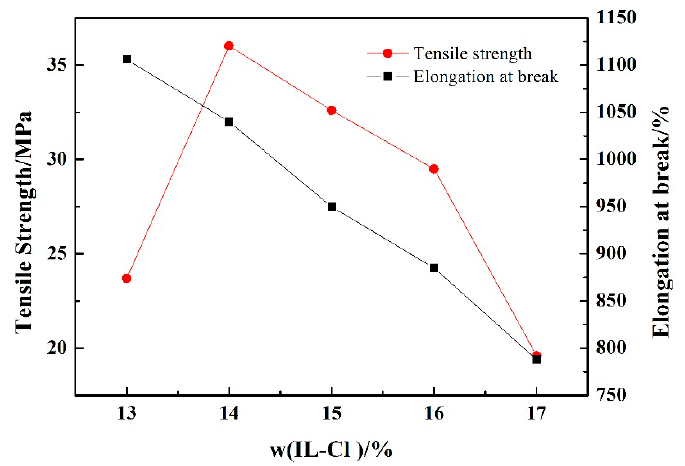
Figure 4. Mechanical property of IWPU films.